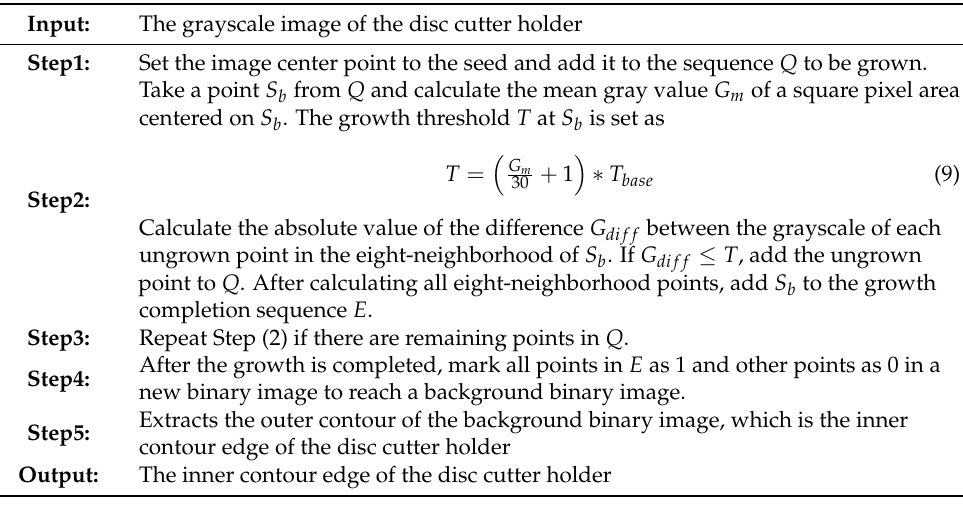
Table 1. Steps of the contour extraction method based on improved region-growing.